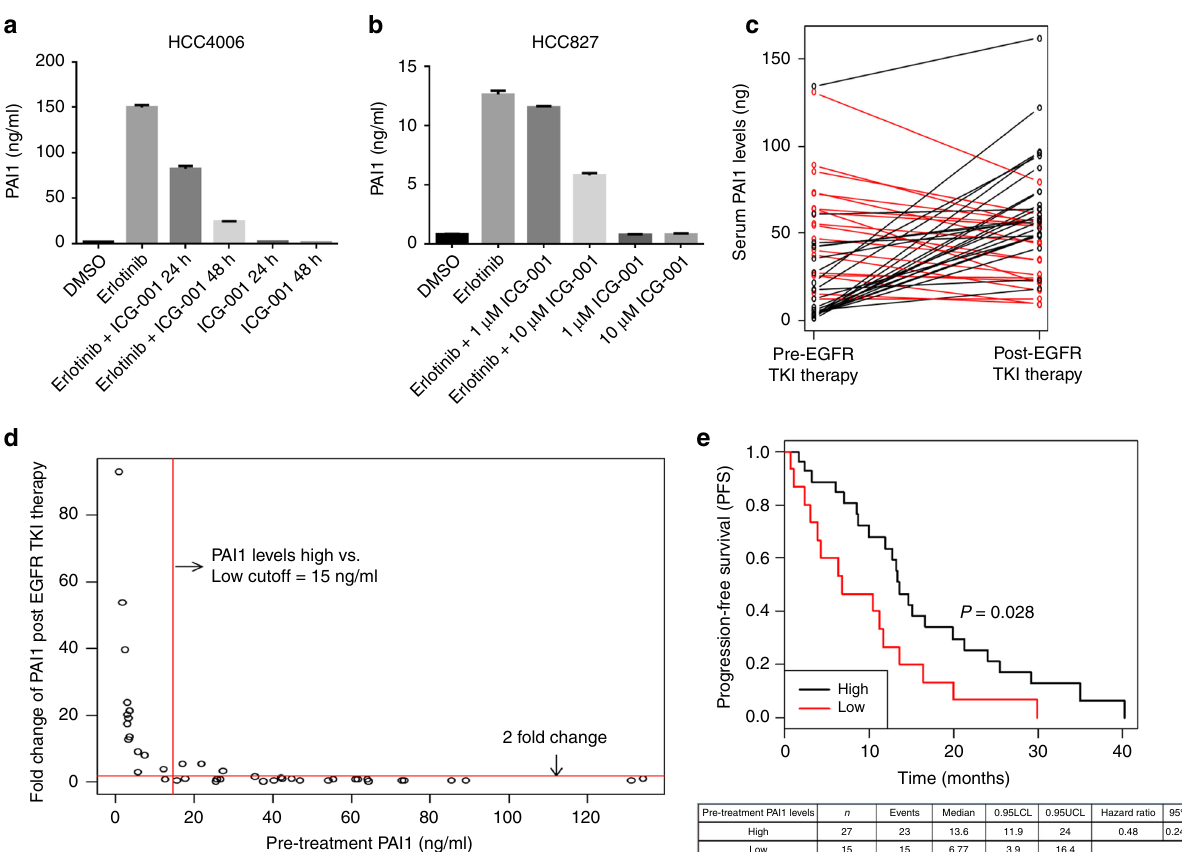
Fig. 10 EGFR TKI therapy induces secretion of PAI1 in patient serum and predicts EGFR TKI resistance in EGFR mutant lung cancer. a , b HCC4006 and HCC827 cells were treated with erlotinib or ICG-001 alone or in combination for indicated time points with indicated doses and soluble PAI1 was measured from cell culture supernatant using PAI1 ELISA. c The serum PAI1 expression before and after EGFR TKI therapy in EGFR mutant NSCLC patients was compared by paired t test. Line graph shows PAI-1 expression was signi fi cantly increased after treatment (54.36 ± 33.89 vs. 35.29 ± 30.81, P = 0.004). Each line represents one patient, connecting the serum PAI1 levels before and after EGFR TKI therapy. Black lines represent the patients who showed increased PAI1 levels after therapy while red lines represent those who do not show change or decreased PAI1 levels after therapy. d , e Patients expressing low levels of pre-treatment PAI1 show an increase in PAI1 levels after EGFR TKI therapy and have a decreased progression free-survival (PFS). d EGFR TKI- induced PAI1 increase in fold changes was plotted against basal PAI1 (ng/ml) levels. Red line parallel to x -axis indicates a two-fold change cutoff in the EGFR TKI therapy-induced PAI1 levels. Red line parallel to y -axis indicates PAI1 levels cutoff (15 ng/ml). e Kaplan – Meier method was used to estimate the progression-free survival (PFS) functions and log-rank test was used to compare PFS of the high and low pre-treatment PAI1 levels. Pre-treatment PAI1 level of 15 ng/ml was used as a cutoff. For ( a ) and ( b ) error bars are